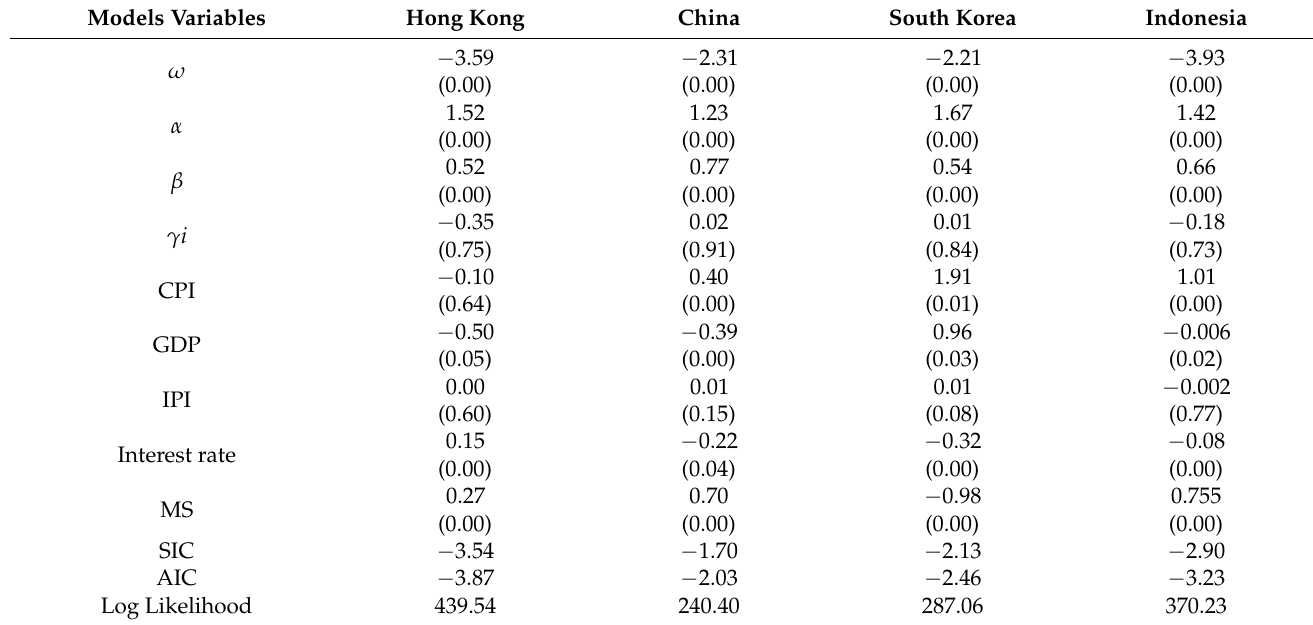
Table 6. EGARCH Analysis of Dynamics of Volatility for pan-Asian Countries over the Period of January 2000 to December 2019. Models